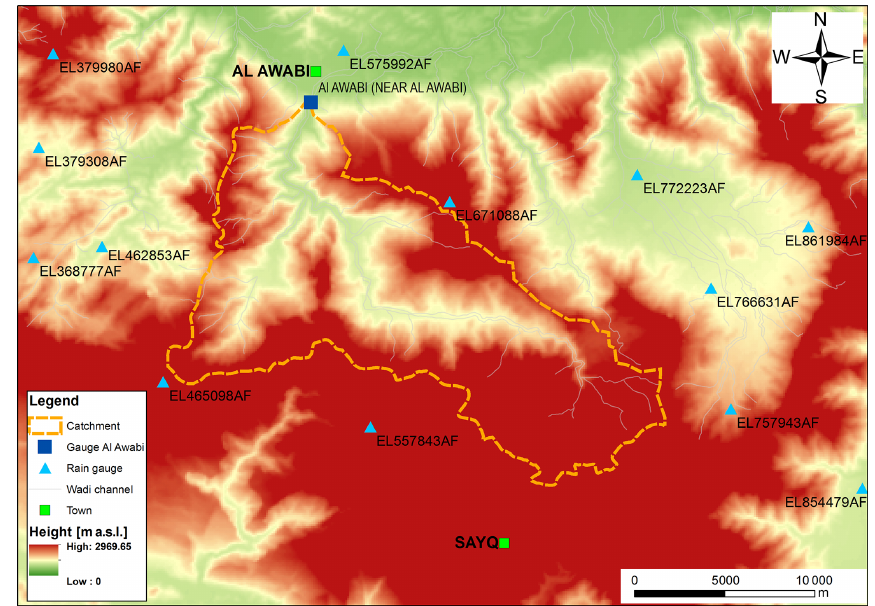
Figure 10. Real-world case study: catchment of gauge Al Awabi and sub-daily monitoring network for runoff and rainfall.